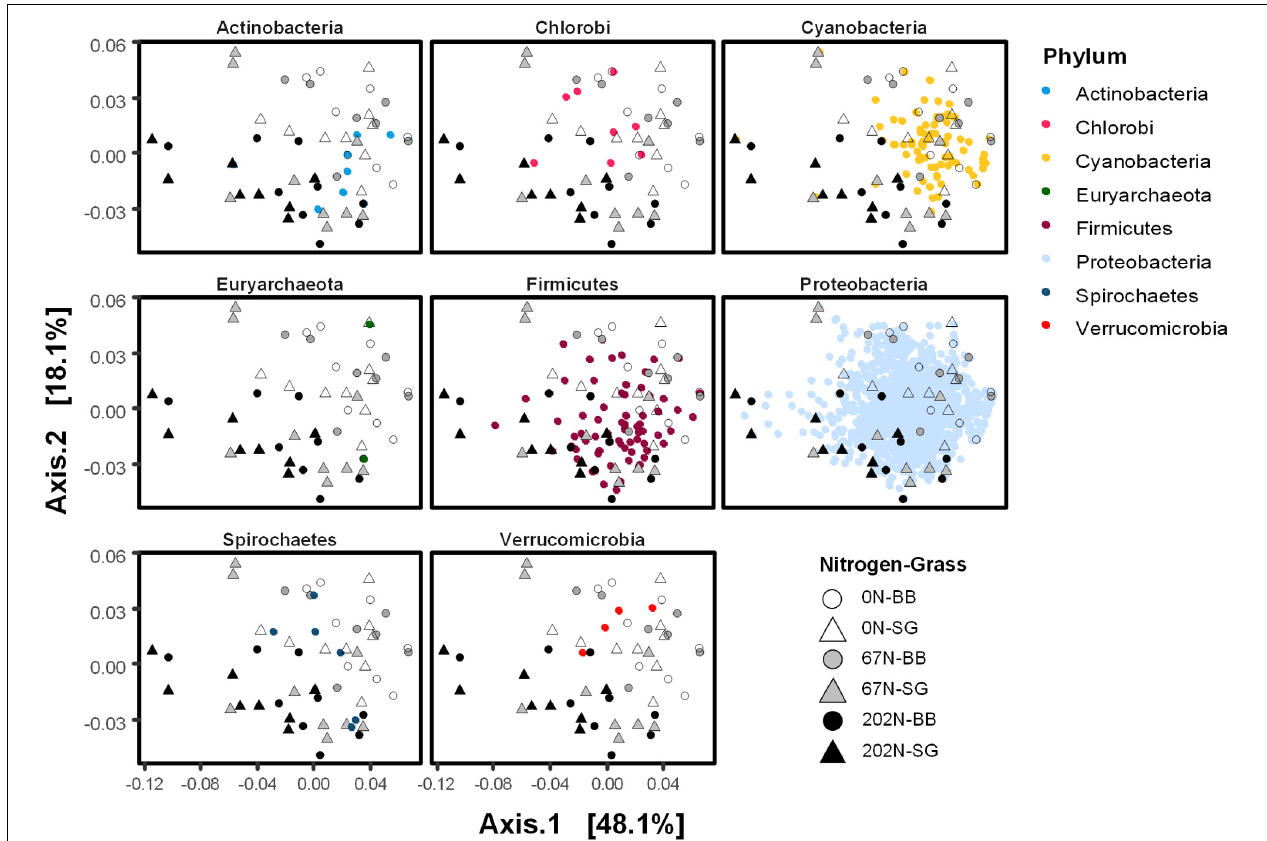
FIGURE 7 | Double principal coordinate analysis (DPCoA) of weighted-UniFrac distance between diazotrophic microbial communities. Both samples and OTU optima were displayed. Small points on the ordination plots represent nifH OTUs and are colored by phylum. Large circle and triangle points on the ordination plots represent samples and are shaped by N fertilization rate and grass species. 0N, no N fertilization; 67N, 67 kg N ha − 1 fertilization; 202N, 202 kg N ha − 1 fertilization; SG, switchgrass; BB, big